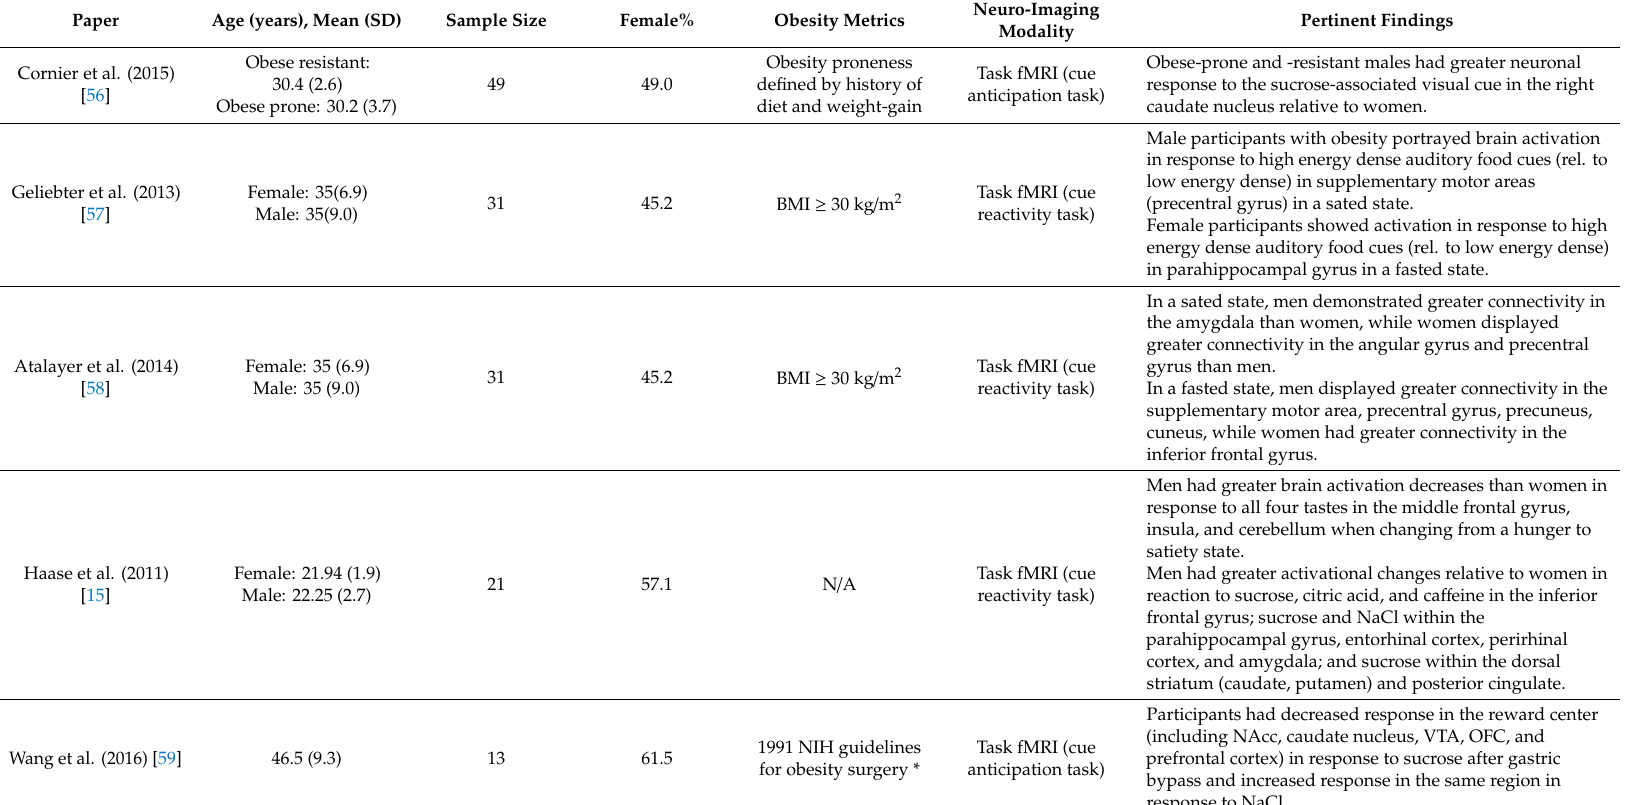
Table 3. Brain taste response study sample characteristics and